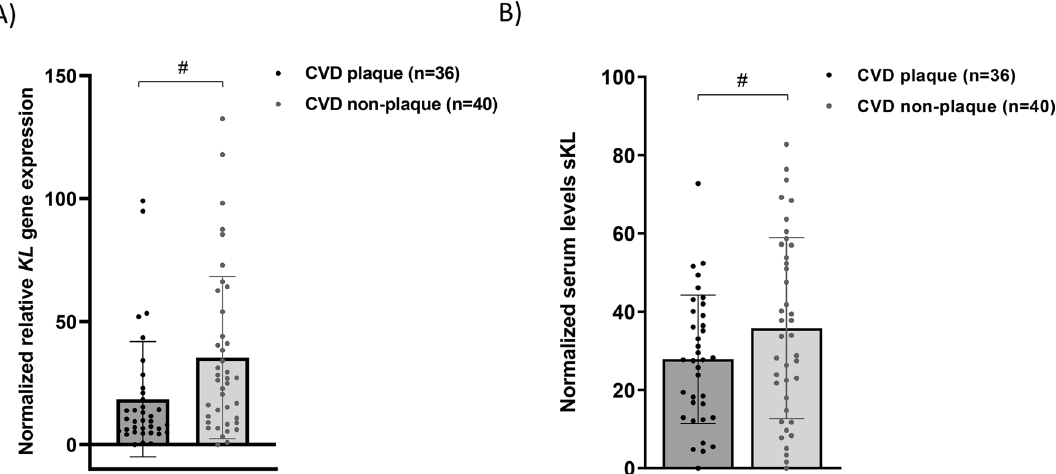
Figure 4. KL levels according to the presence of developed atherosclerotic plaque in CVD patients. ( A ) Relative gene expression levels of KL locus in PBCCs, ( B ) Serum levels of sKL (pg/mL). a.u.: arbitrary units. Bars and range represent median and IQR. **: P < 0.01; ****: P < 0.0001 vs non-CVD group; #: P < vascular damage [Normalized RQ: 9.66 (5.18 to 20.33) versus 26.53 (9.46 to 51.56), P < 0.05]. Similarly, serum sKL concentrations in patients with developed atherosclerotic plaque in the tissue sample were significantly lower [Normalized serum levels: 27.87 ± 16.43 versus 35.78 ± 23.10, P < 0.05] (Fig. 4). To study the association of these KL elements with the presence or absence of CVD and of atherosclerotic damage, we developed multiple logistic regression analyses with iterative models that included classic cardiovas- cular risk factors (model 1), PBCCs and serum inflammatory markers (model 2), and KL expression in leukocytes and serum sKL levels (model 3). In a final adjusted model, we observed that expression in PBCCs of KL gene and serum sKL concentration were protective factors for the presence of both CVD and developed atherosclerotic plaque (Table 4, Supplementary Fig. S3).